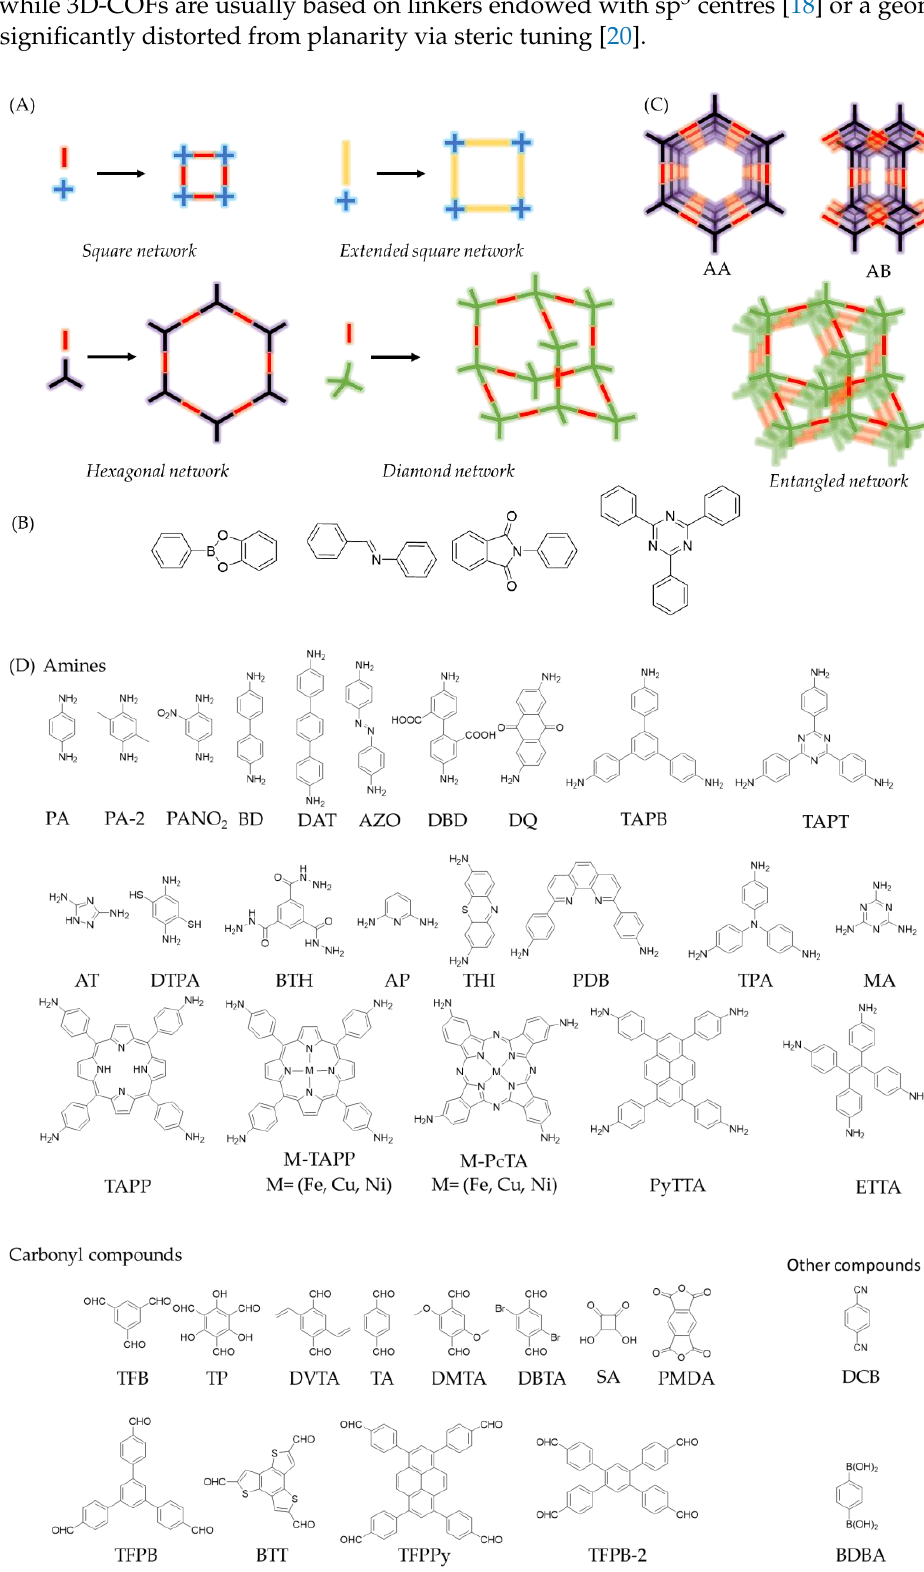
Figure 1. ( A ) Examples of COFs topology diagrams. ( B ) Examples of linkages commonly used for the synthesis of COFs (from left to right: boronate ester, imine, imide, and triazine. ( C ) Examples of arrangements of COF’s networks. ( D ) List of linkers named in this review.